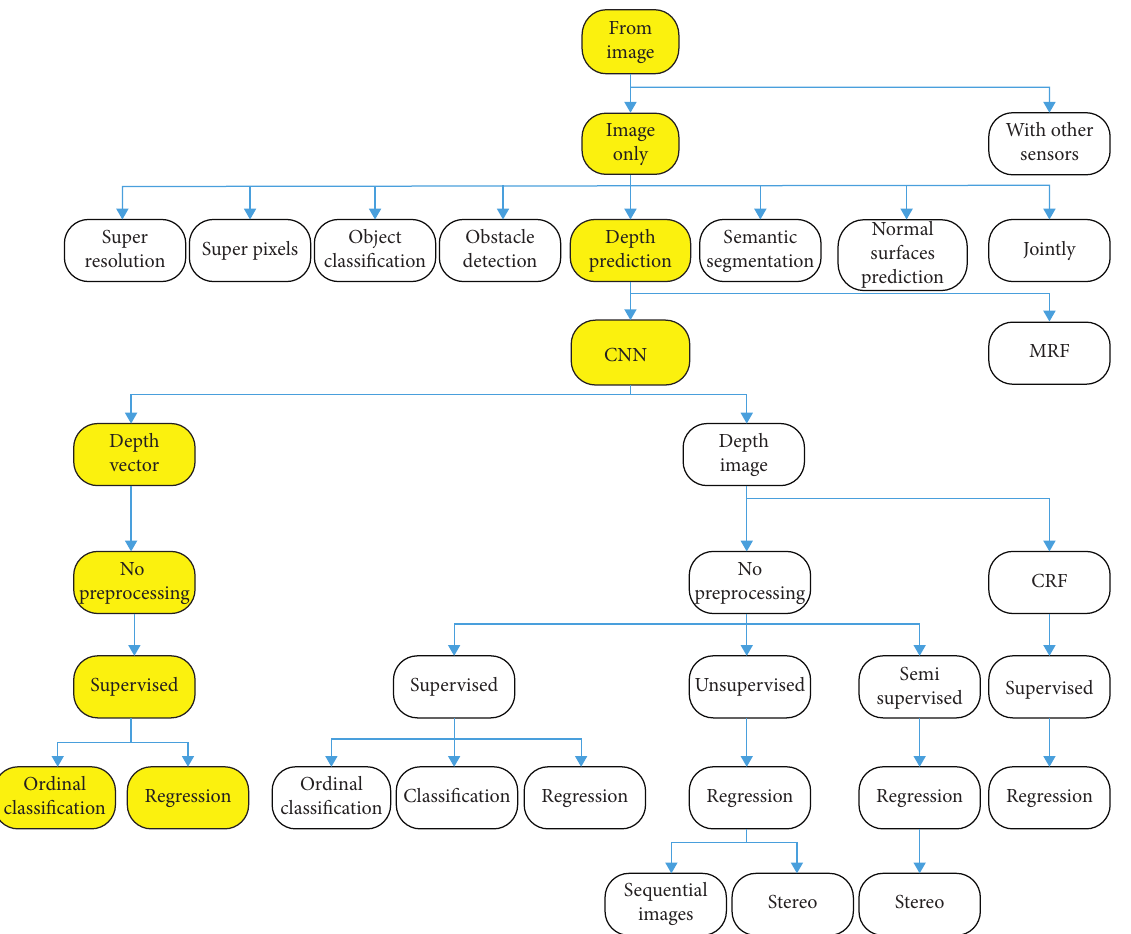
Figure 1: Tree of major problems related to depth prediction.